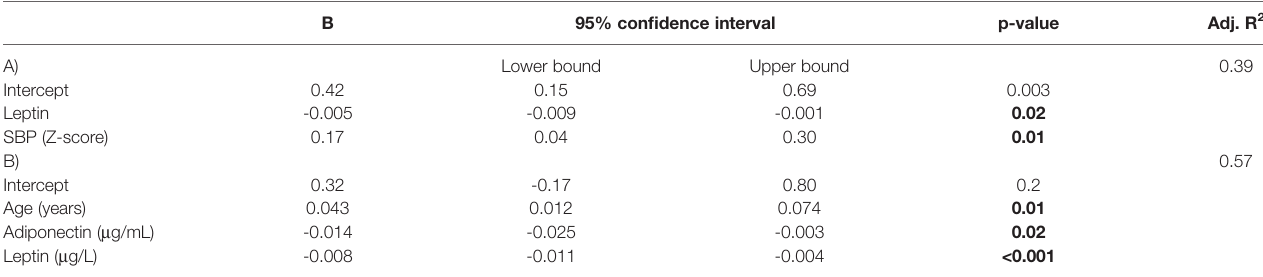
TABLE 5 | Linear regression identifying pre-treatment predictive factors for absolute BMI SDS change (for most patients an increase) (A) and BMI SDS regain (B) after inpatient treatment (n=43). B Adj. R 2